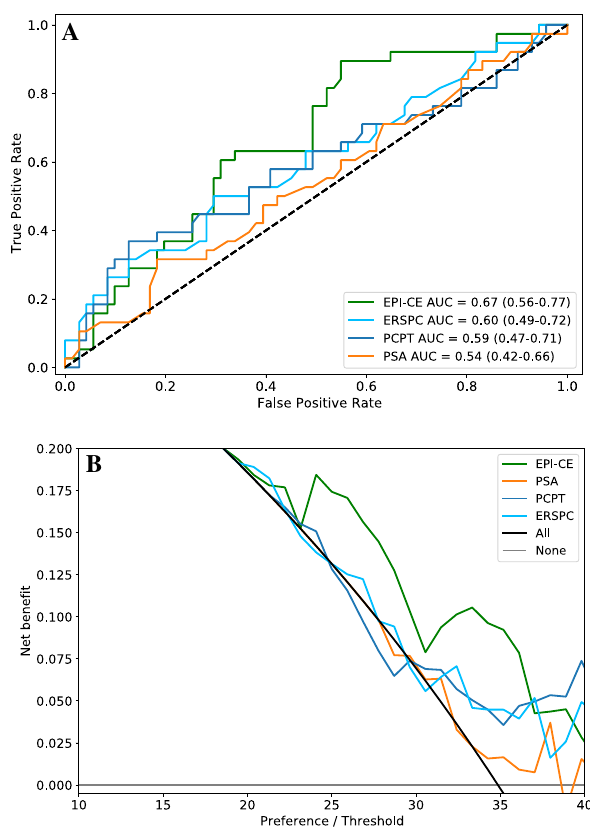
Figure 2. Receiver-Operating-Characteristics Curve and Decision Curve/Net Benefit analysis of EPI-CE compared to PSA and the two multiparametric risk calculators, PCPT and ERSPC, showing that the EPI-CE score provides a higher Area-Under-Curve (AUC) and a higher Net Benefit than either of the multivariate risk calculators across a wide range of risk acceptance